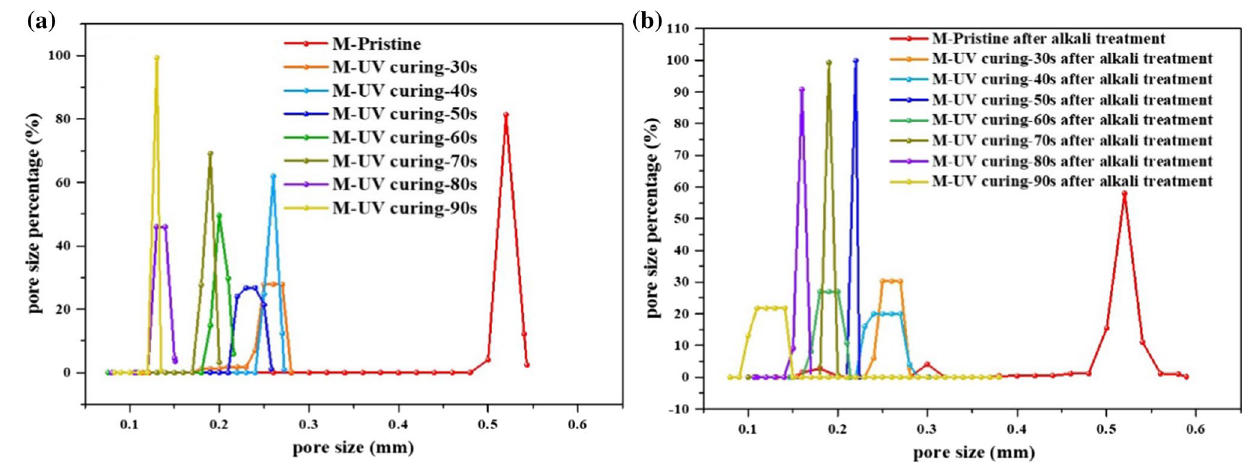
Fig. 9 a The effect of curing time on pore size before alkali treatment. b The effect of alkali treatment on membrane pore size distribution